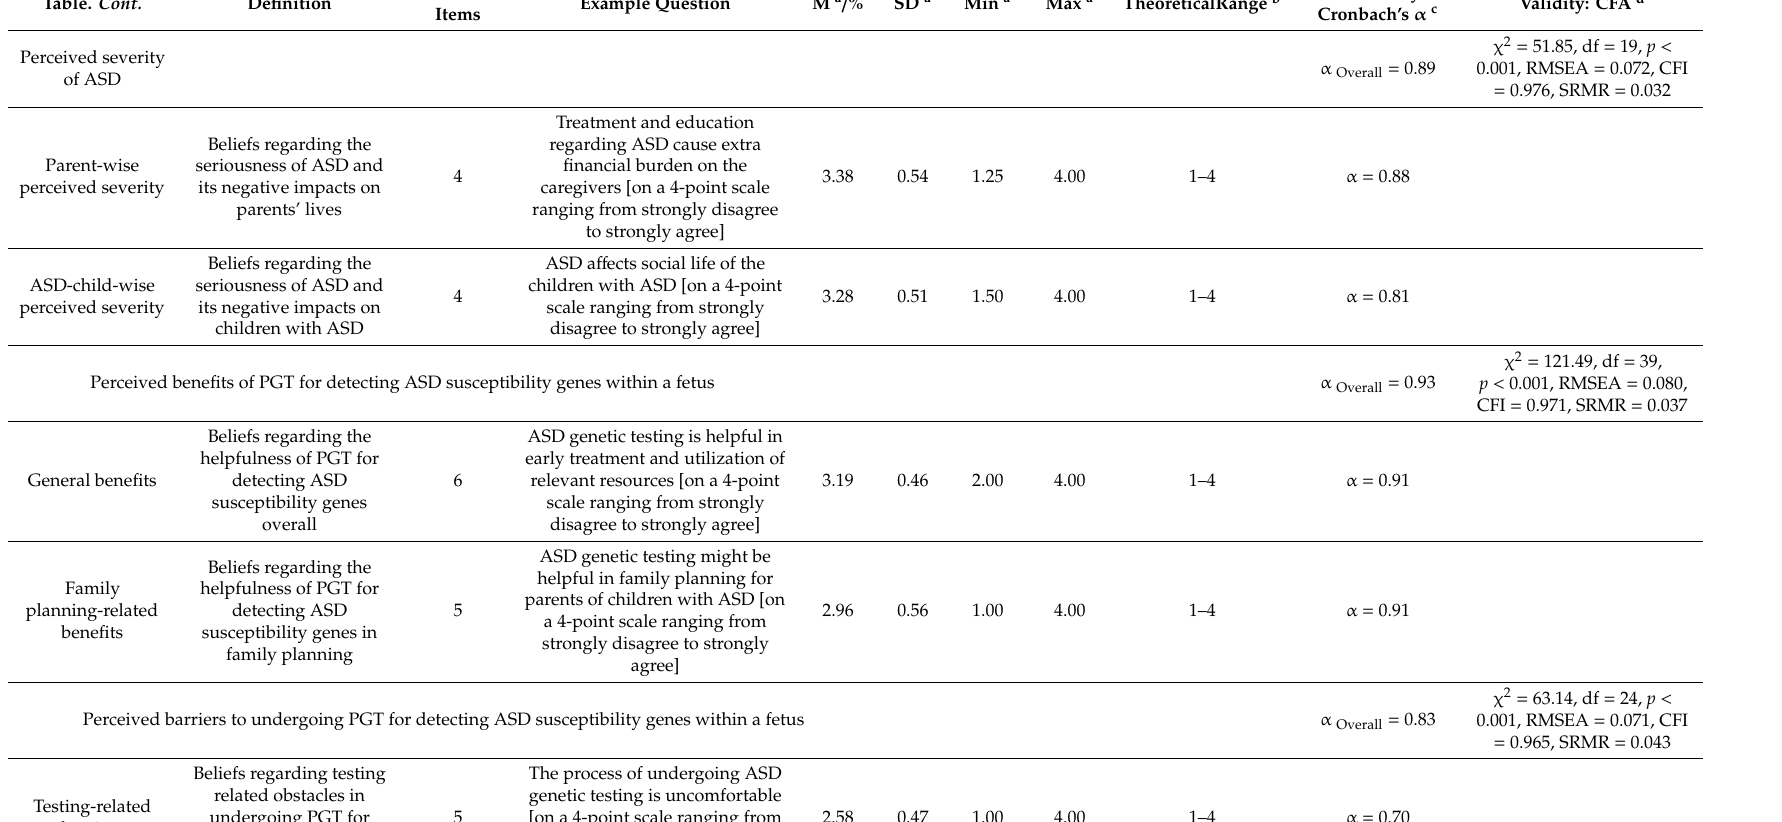
Table 2. Description, reliability, validity, and example questions of the psychosocial constructs measured in the survey. Table.